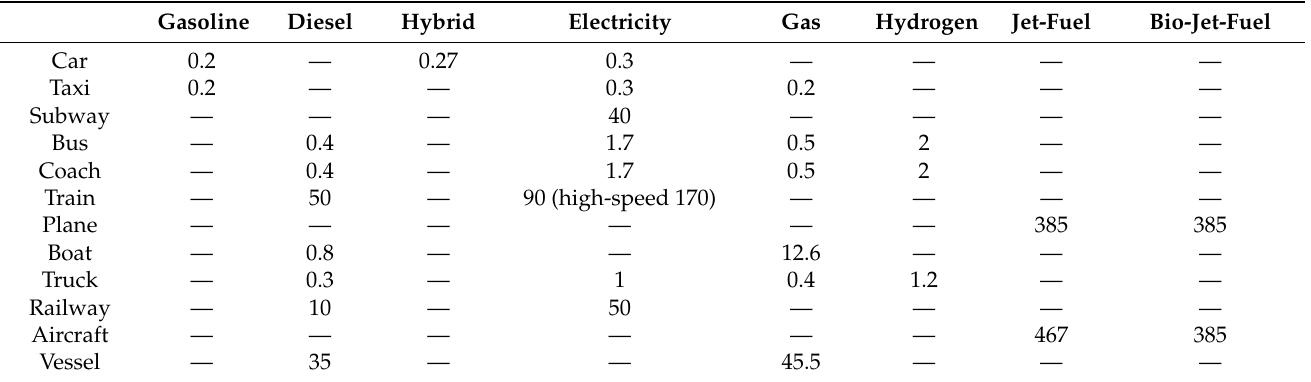
Table A2. Investment costs of vehicles in 2020 (CNY million).